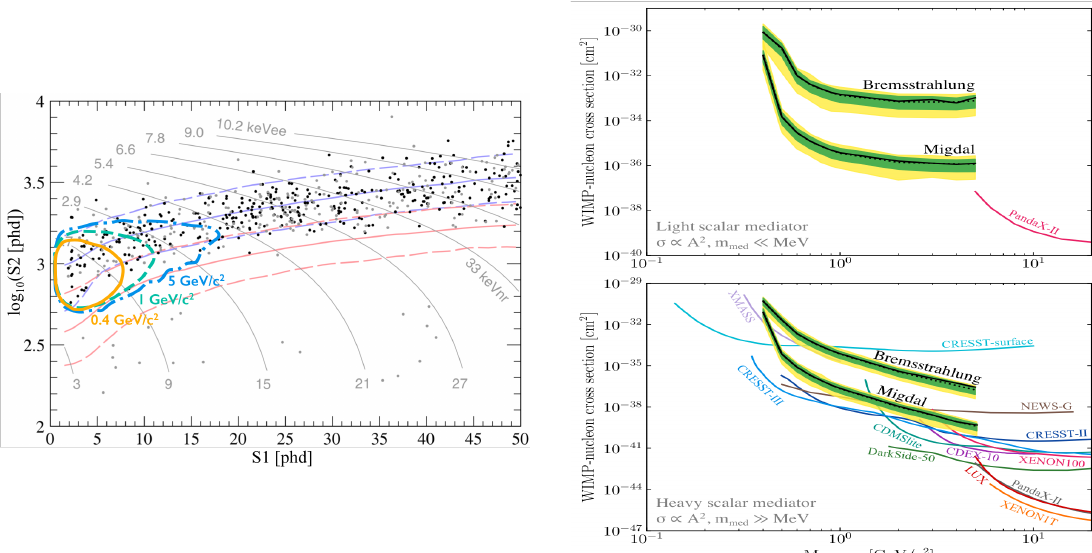
Figure 2. ( Left ) Contours containing 95% of the expected WIMP signal from the bremsstrahlung and Migdal effects. Different contours indicate expected signal in different models: bremsstrahlung signal from 0.4 GeV/c 2 WIMPs assuming a heavy scalar mediator, Migdal effect from 1 GeV/c 2 WIMPs assuming a heavy scalar mediator, and Migdal effect from 5 GeV/c 2 WIMPs assuming a light vector mediator (see text for detail). ( Right ) WIMP-nucleon cross section limits at 90% C.L., as calculated using the bremsstrahlung and Migdal effect signal models assuming a scalar mediator (coupling proportional to A 2 ). The 1 σ and 2 σ ranges of background-only trials for this result are shown as green and yellow bands, respectively, with the median limit shown as a black curve. The top figure presents the limit for a light mediator with the reference value for the 4-momentum transfer in the form-factor q ref = 1